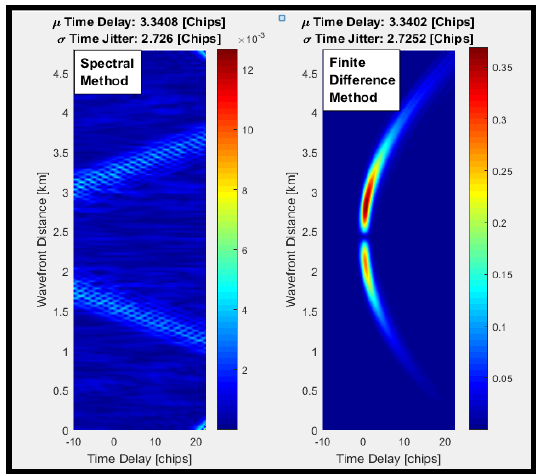
Figure 8. Global Error difference (Gaussian Lens Interaction) A well-defined band occurs on the right side of Figure 8 as a result of the FDM algorithm solution mismatch with the analytic solution. The left side shows no such band as the SM algorithm generally agrees with the analytic solution and has minimal inaccuracies.